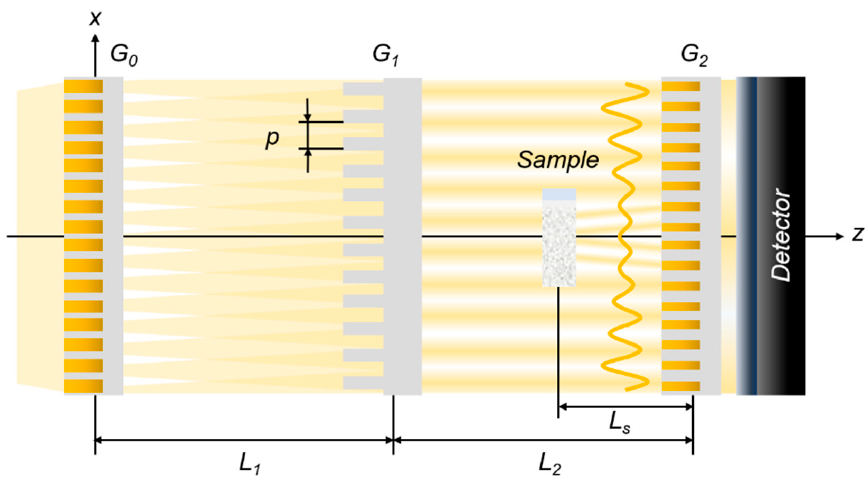
Figure 2. Schematics of the Talbot–Lau neutron grating interferometer. Small-angle neutron scattering from a sample convolutes with the intensity modu- lation induced by the gratings. This results in the damping of the interference fringes at G 2 , i.e., a loss of visibility, v s . The relative loss of visibility, v s / v o , is referred to as the DFI contrast. The scattering distribution at G 2 varies with the sample distance L s and the wavelength λ , and it can be shown that these parameters, together with the beam modulation period p , define the real-space length probed in the scattering structure [19]. This length is referred to as instrumental or probed correlation length, ξ , in full analogy to the spin-echo length in SESANS. It can be written as: